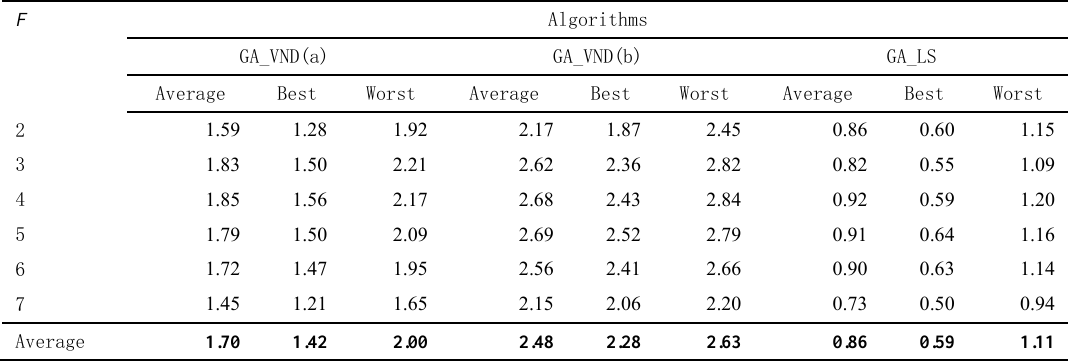
Table 7. Average RPD of genetic algorithms using CPU times of GA_VND(b) as time limits F